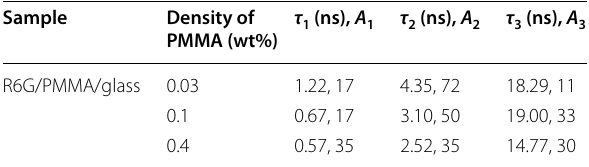
Table 2 Lifetime R6G/PMMA/glass samples Sample